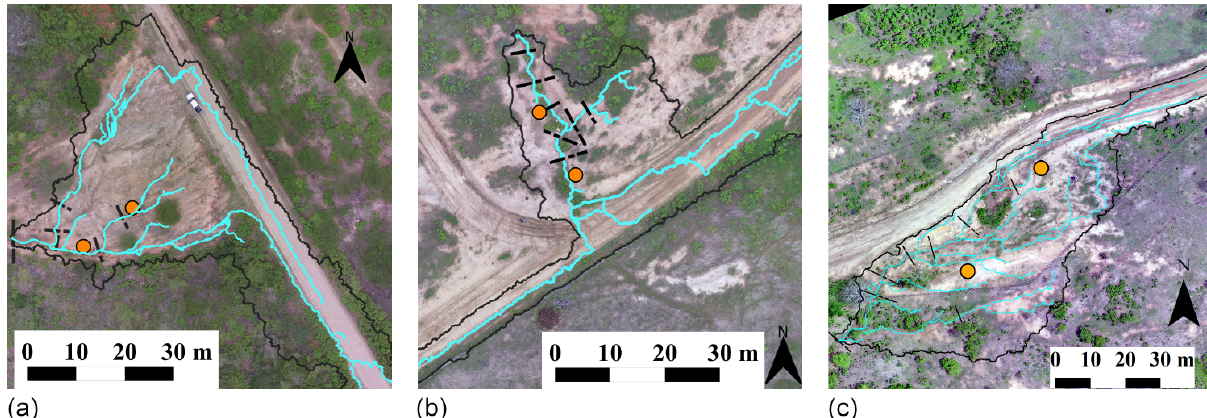
Figure 3. Aerial photogrammetry of the gullies studied. Note that they are at the margin of the road, receiving the concentrated flow diverged from it. The continuous black line represents the catchment boundaries; the blue line represents the flow paths; the dashed black lines are the cross sections used in the validation of the model; and the orange dots are the soil sampling points: (a) gully 1, (b) gully 2 and (c) gully 3.